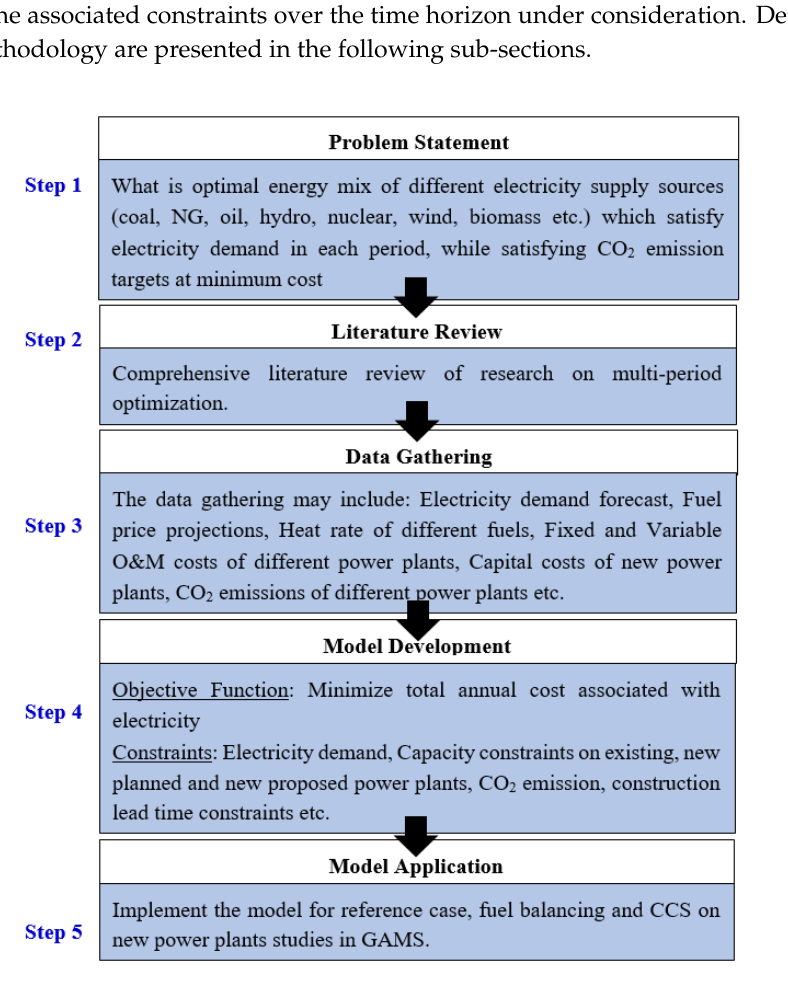
Figure 5. Steps involved in methodology.